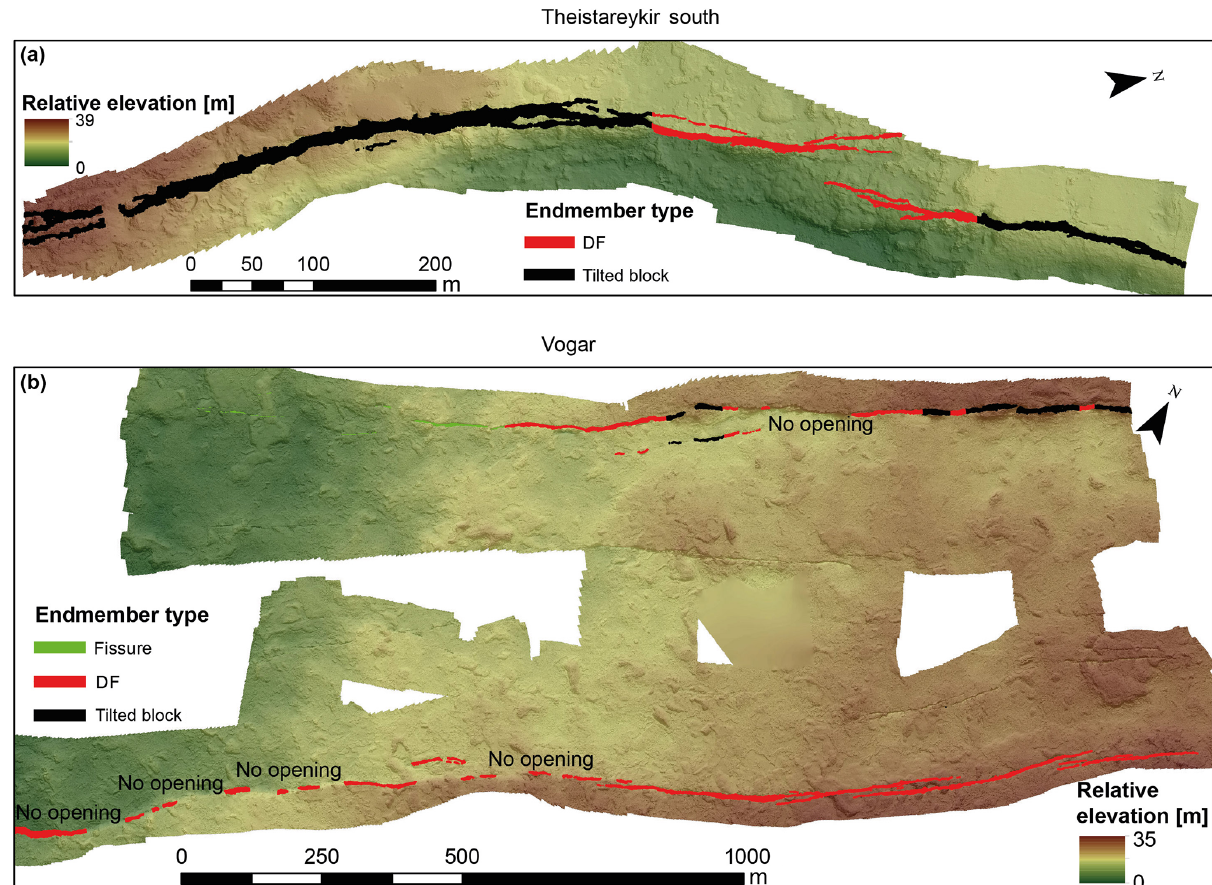
Figure 18. (a) DEM and proposed endmember types of the fractures of the Theistareykir fissure swarm. (b) DEM and proposed endmember types of the fractures of the Vogar fissure swarm. Projection of the DEM: WGS1984 UTM 28N (a) and UTM 27N (b) .